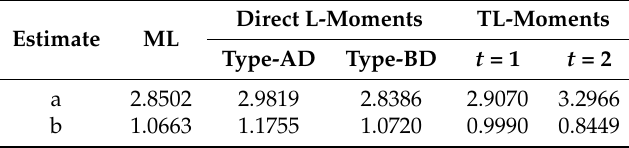
Table 7. Maximum likelihood (ML), direct L-moments, and trimmed L-moments